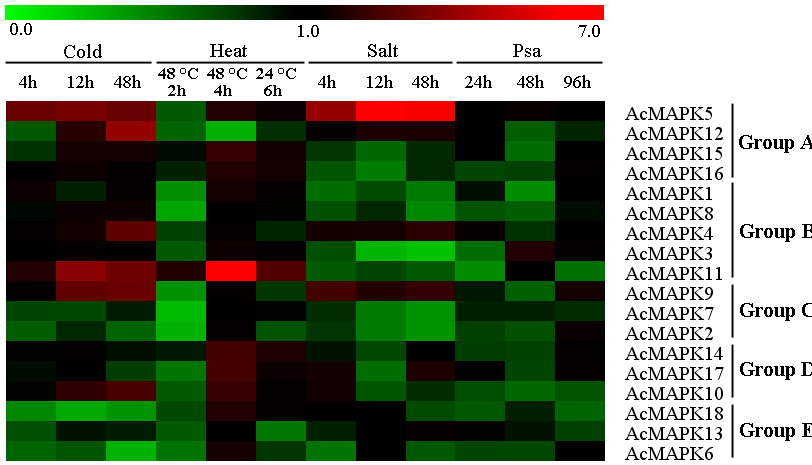
Figure 5. Hierarchical clustering of the expression profiles of AcMAPK genes in response to various biotic and abiotic stresses. Cold: treatment at 4 °C; Heat: treatment at 48 °C and 24 °C; Salt: treatment with NaCl; Psa: Pseudomonas syringae pv. actinidiae infection. Details of the treatments are reported in Materials and Methods. The heat-map depicts the fold-change of the relative expression of all AcMAPK genes in response to the various treatments in comparison to their respective controls. Red and green colors represent increased or decreased expression levels, respectively, in comparison to controls, as reported by the scale. Genes were clustered according to phylogenetic relationships in expression profiles. Relative expression values for each gene and each treatment are provided in Figures S6 and S7.